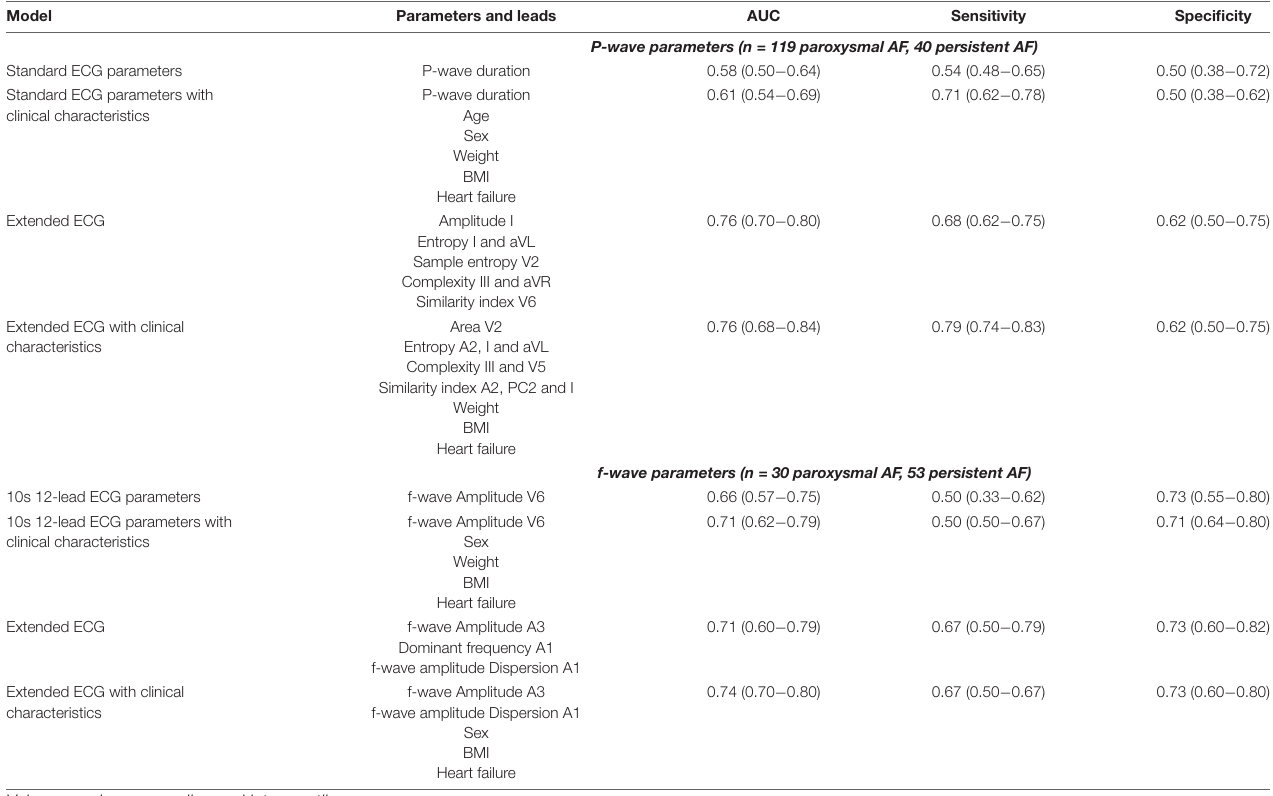
TABLE 4 | Classification of AF type based on P-wave parameters and f-wave parameters.